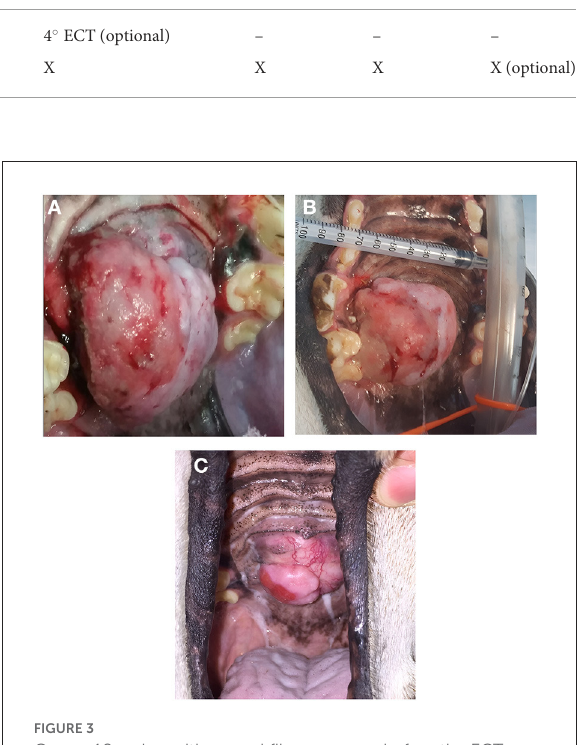
stage, tumour localization, MST, DFI, PFS and outcome are summarized in Table 3, and stratified for tumour